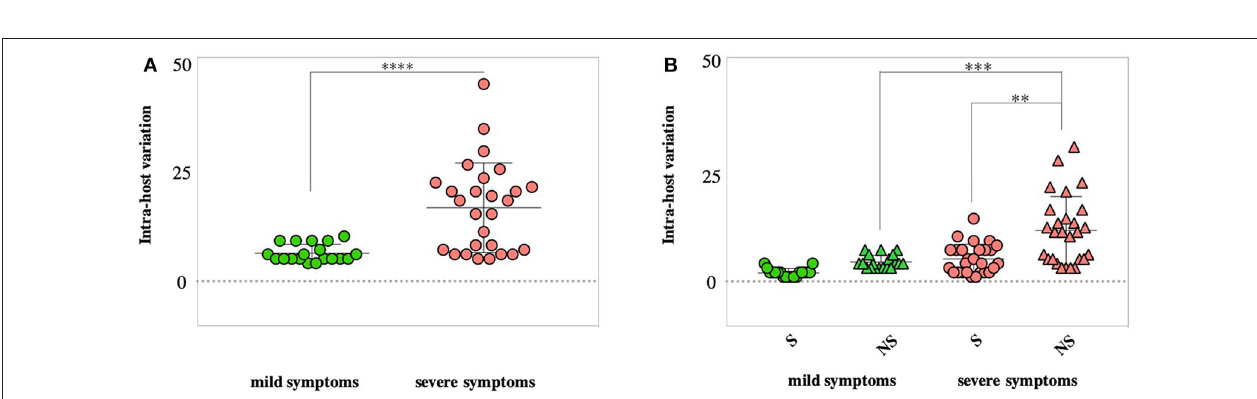
FIGURE 5 | Variants in the SARS-CoV-2 spike glycoprotein. (A) Genomic position and frequency of variants detected in S genes of all viruses. (B) Schematic representation showing consensus mutations found in mild (green) and severe (red) cases. D614G mutation was found in both mild and severe cases.